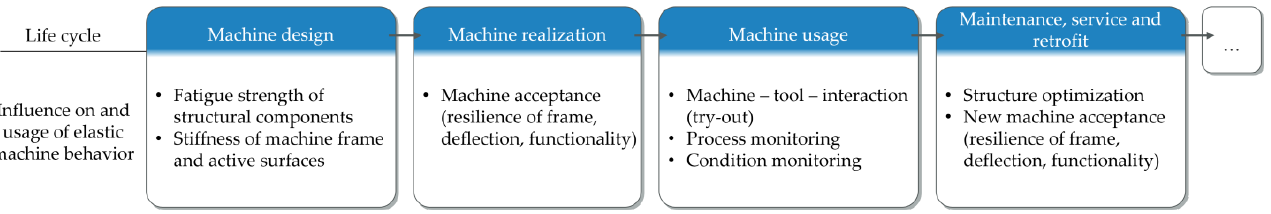
Figure 2. Influence on and use of elastic machine behavior in the machine life cycle.